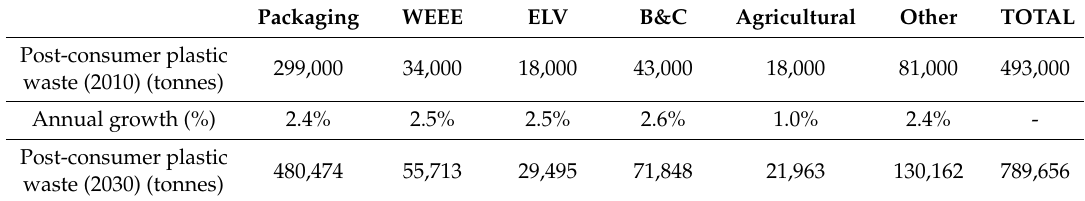
Table 5. Annual growth rate of waste generation and future waste amounts, by waste